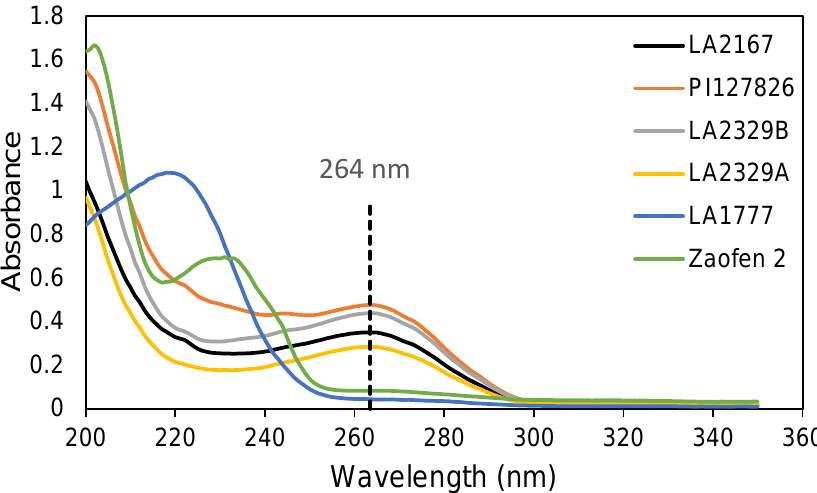
Figure 5. Examples of UV-absorbance spectra for hexane leaflet washes from five accessions of Solanum habrochaites and one tomato ( S. lycopersicum ) variety, Zaofen 2. The vertical dashed line identifies 264 nm, the λ max in the 250–280 nm region of the spectra for accessions that produce 7-epi zingiberene and its oxidized forms.